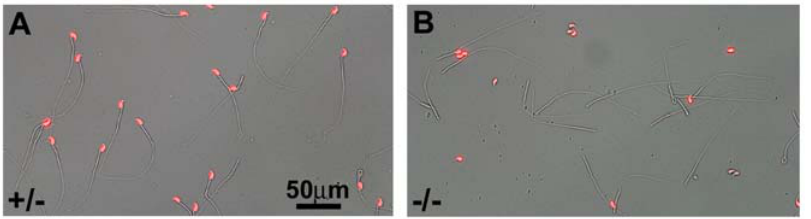
Figure 5. Characteristics of OAZ-t -null sperm. Epididymal sperm were cultured in TYH medium for 1 h. The OAZ-t -null heads were easily separated and aggregated. The nuclei were stained with PI after PFA fixation. Analysis of OAZ-t -null sperm by optical microscopy.